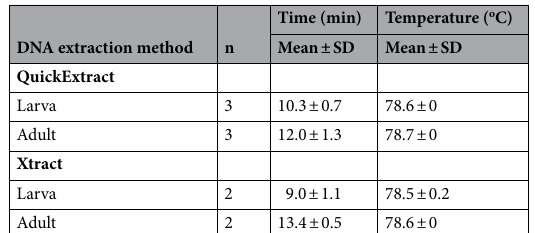
Table 4. In-field compatible non-destructive DNA extracted from a single thoracic leg of FAW caterpillar or moth using two different extraction buffers tested for FAW LAMP assay.